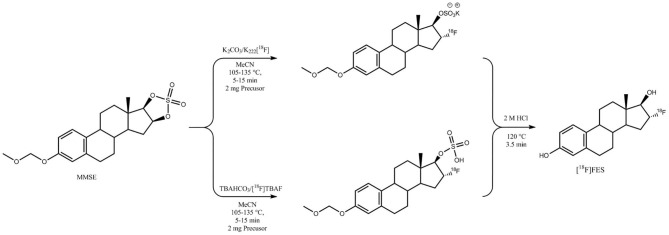
Scheme for the production of 16α-[18F]FES catalyzed by K222/K2CO3 or TBA·HCO3.